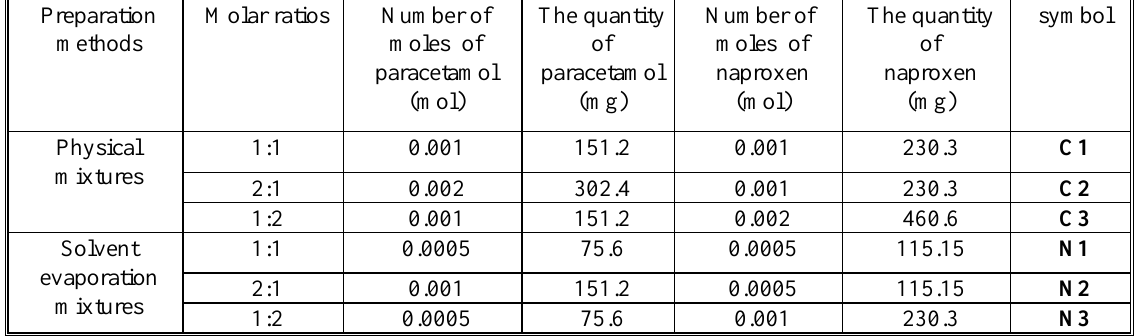
Table 1. All prepared co-crystals and physical mixtures with their different molar